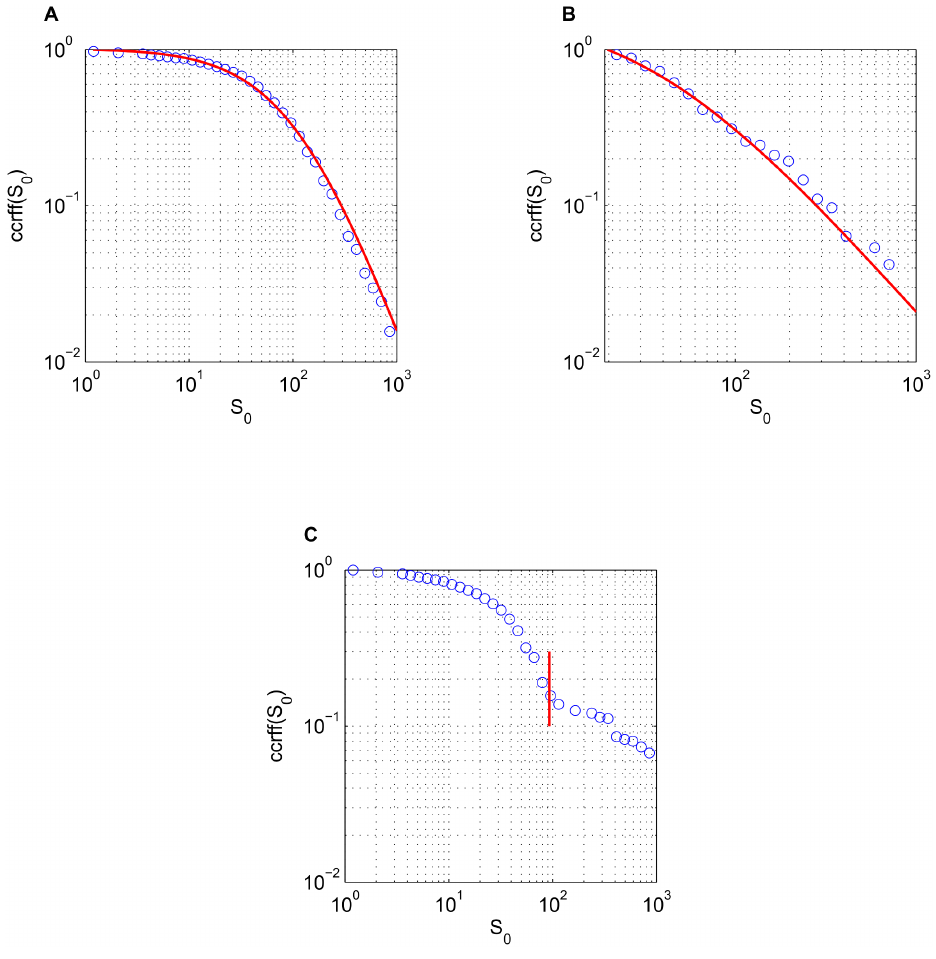
Figure 2. Complementary cumulative relative fluctuation function. The ccrff, equation (5), as a function of the initial population size S 0 . For Renren and Twitter the ccrff is well fitted by shifted power law * ( S 0 { C ) { n , with C a constant: (a) Result for Renren: n rr ~ 1 : 828 ( R 2 ~ 0 : 997 ). (b) Result for Twitter: n tw ~ 1 : 324 ( R 2 ~ 0 : 995 ). (c) For Gowalla the ccrff is bimodal with a cutoff point at S (cid:2) & 93 (obtained from MLE, see methods): the left part is well fitted by an exponential and the right part is in good agreement with a power law decay, ccrff ( S 0 ) * e { m S 0 for S 0 v S (cid:2) , and ccrff ( S 0 ) * S { n for S 0 § S (cid:2) . Fit exponents m gw ~ 0 : 009 ( R 2 ~ 0 : 997 ), and n gw ~ 0 : 13 ( R 2 ~ 0 : 966 0